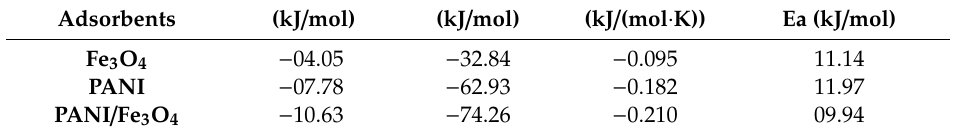
Figure 13. ( a ) Arrhenius plot for calculation of activation energy. ( b ) The van’t Ho ff plot for calculation of enthalpy and entropy.